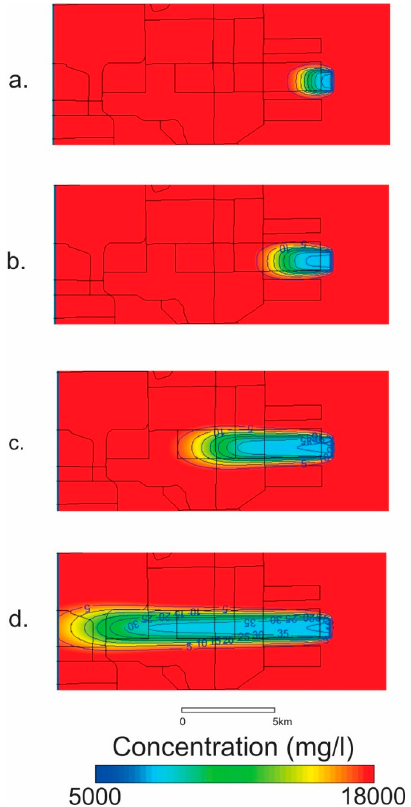
Figure 6. Solute-transport modeling results showing the movement of the injected freshwater plume at 1 ( a ), 2 ( b ), 5 ( c ), and 10 ( d ) years with a gradient of 1.9 × 10 − 4 .